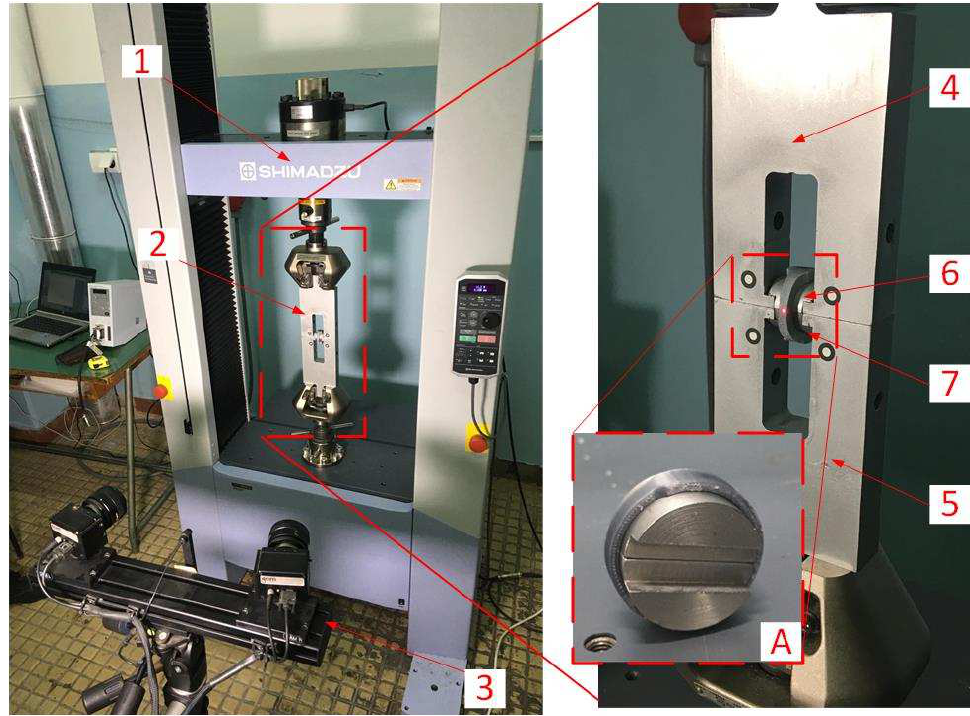
Figure 2. Detailed view of testing setup: (1) tensile testing machine; (2) PRTS testing tool; (3) Aramis 2M; (4) upper fork; (5) lower fork; (6) two D- blocks; (7) PRTS, label (A) assembly of PRTS and D blocks.